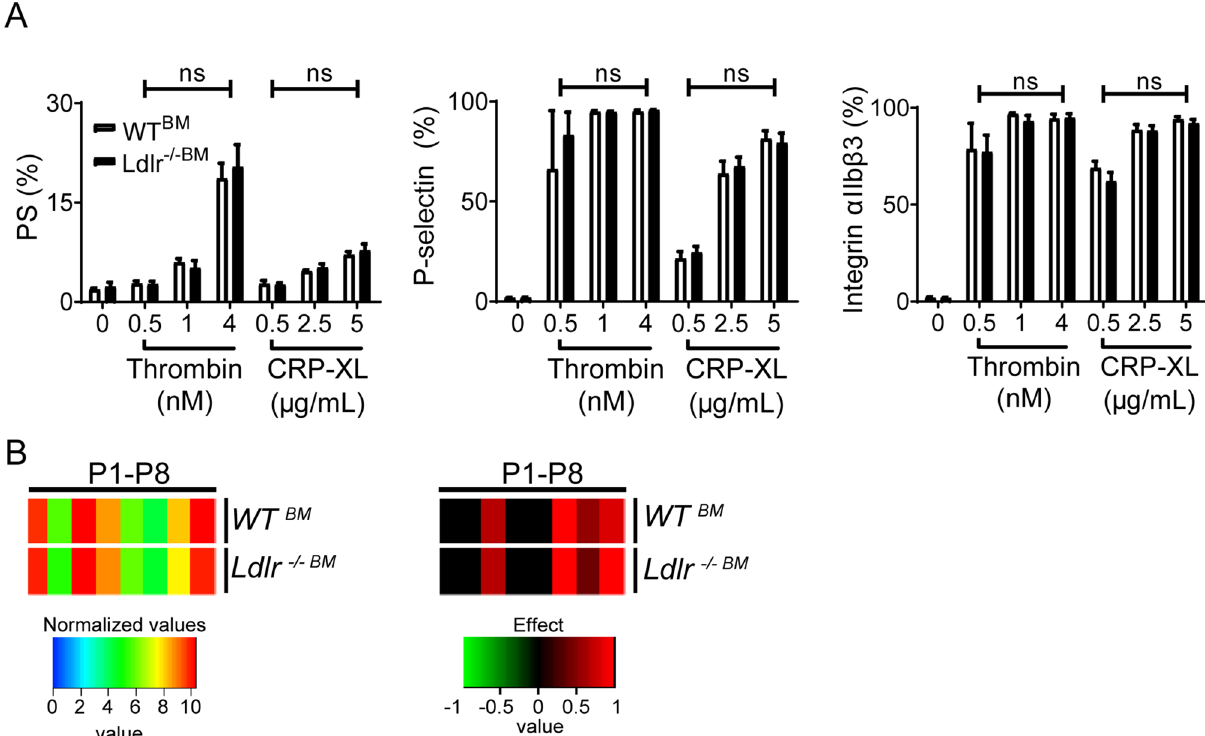
Figure 5. Similar activation of wild-type and Ldlr deficient platelets after transplantation of Ldlr-deficient mice. Bone marrow transplantations were performed using bone marrow from either wild-type (WT BM ) or Ldlr −/− mice (Ldlr −/− BM ) injected into irradiated Ldlr −/− recipients, held on normal chow diet. ( A ) Isolated platelets were activated by thrombin (0.5–4 nM) or cross-linked collagen-related peptide (CRP-XL, 0.5–5 μg/ml), and exposure of PS, P-selectin and activation of integrin α IIb β 3 were determined by flow cytometry using AF647- labeled annexin A5, FITC-labeled anti-CD62P mAb, or PE-labeled JON/A mAb, respectively. Means ± SEM ( n = 4–8 animals/group). ( B ) PPACK-anticoagulated blood was perfused over collagen type I at wall shear rate of 1000 s −1 . Brightfield images were captured, after which the deposited platelets were stained for integrin α IIb β 3 activation, P-selectin expression and PS exposure in different colors. Platelet activation parameters were obtained, as described for Fig. 1. Left: Scaled heatmap with integration of age groups. Right: Scaled heatmap of effect sizes per genotype. Effect size per parameter was calculated from the pooled standard deviation, Cohen’s d and regression coefficient